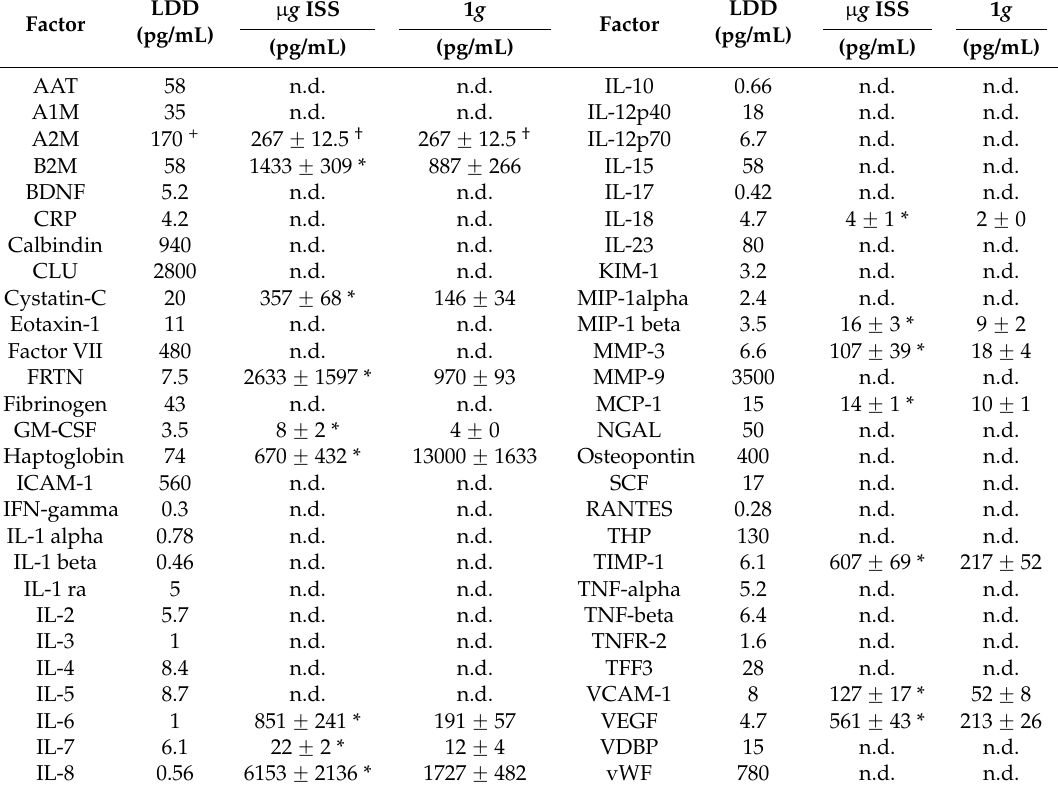
Table 1. Proteins searched in supernatants of FTC-133 cells with the help of multi-analyte profiling (MAP)